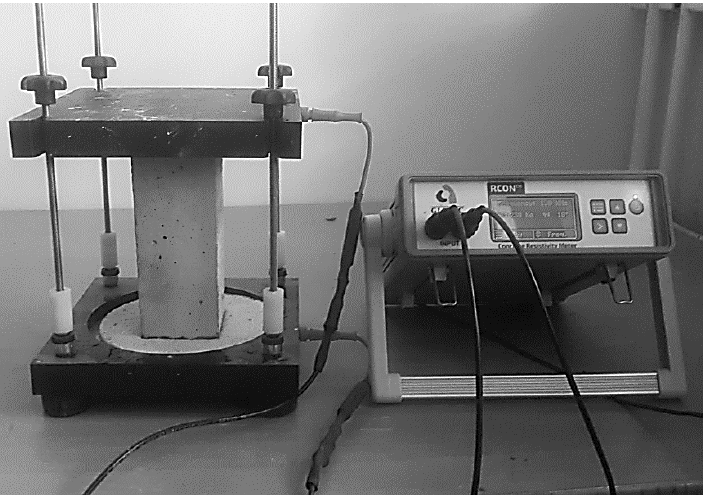
Figure 3. Example of measuring the volumetric resistivity of a prismatic sample.